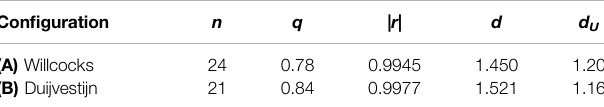
TABLE 1 | Comparison of two perfect squared